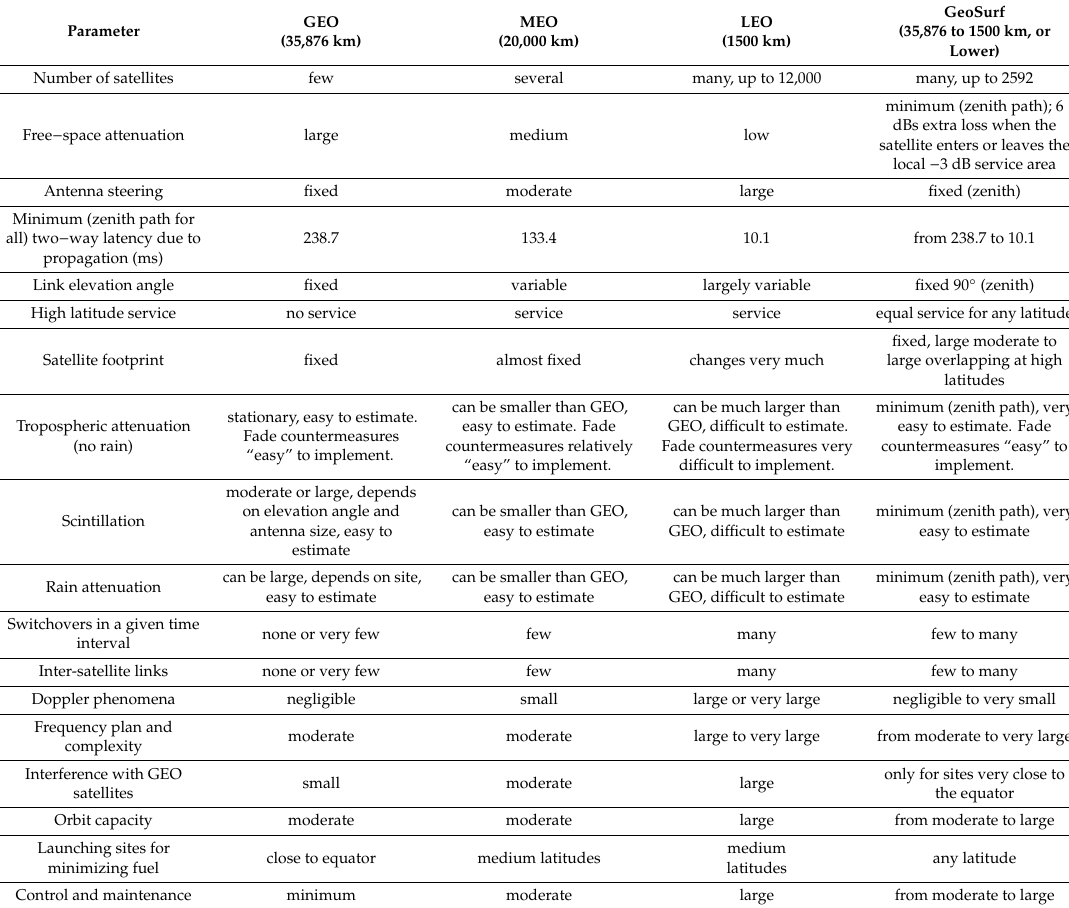
Table 1. General characteristics (advantages and disadvantages) of the most popular constellations (identified by their altitude above the Earth surface) compared to the GeoSurf constellation. It is assumed that the frequency band and worldwide communication service type are the same for all